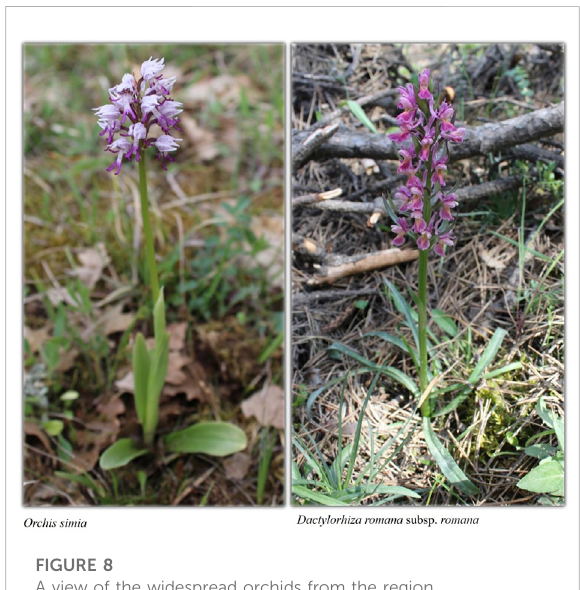
FIGURE 8 A view of the widespread orchids from the